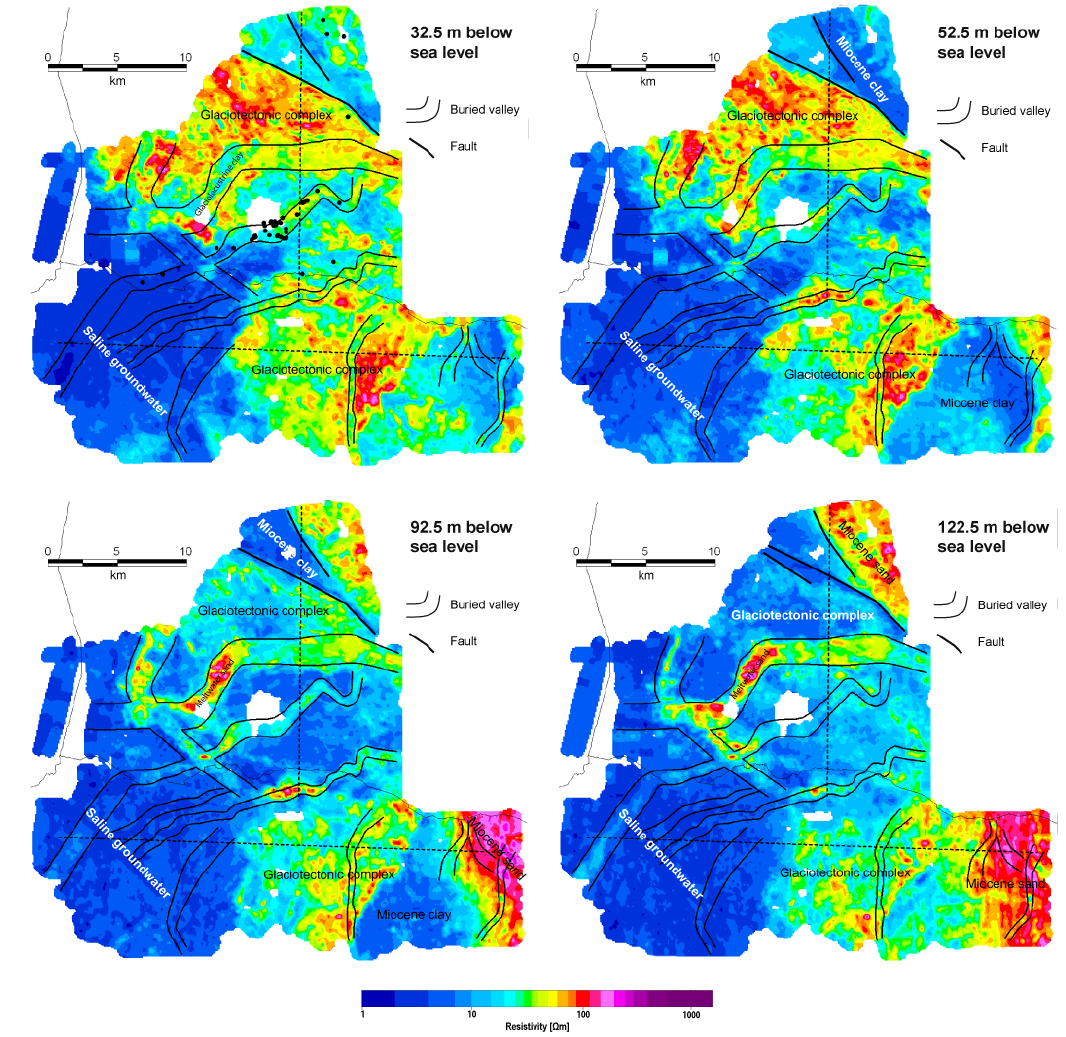
Fig. 10. Horizontal resistivity slices at four selected levels. Mapped buried valleys are outlined on the maps, but not necessarily expressed in the resistivity data at each level. Boreholes with interglacial marine clay recordings are marked as black dots on 32.5m below sea level. This particular valley was apparently inundated by the sea during the last interglacial. Location of the two SkyTEM profiles 1 and 2 shown in Fig. 11 are marked with dashed